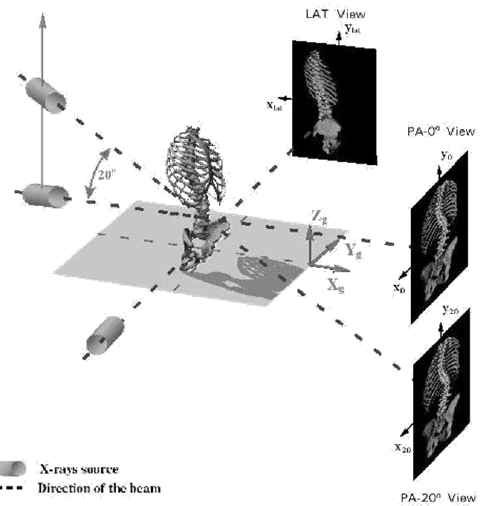
Figure 6. Three-dimensional radiographic images acquisition setup; Source: (Delorme et al., 2003)